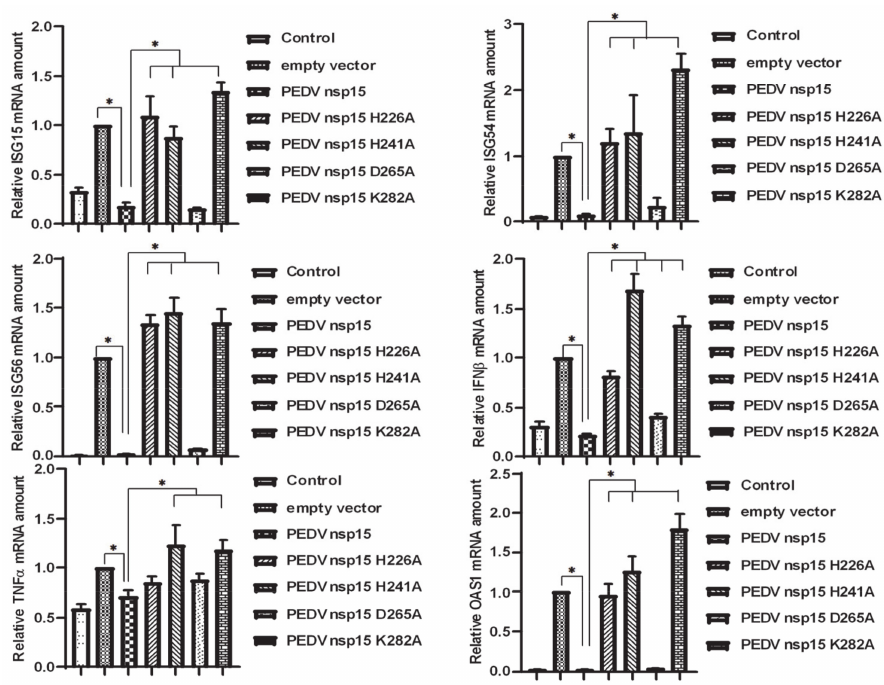
Figure 7. PEDV nsp15 negatively regulates TBK1 and IRF3 mediated induction of antiviral molecules. HEK293T cells were cells were co-transfected with TBK1 and IRF3 along with PEDV nsp15 expression plasmid (PEDV nsp15, H226A, H241A, D265A or K282A) or empty vector for 36 h. The RNA